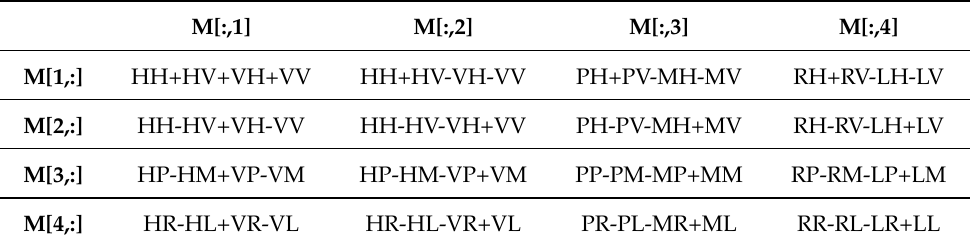
Table 1. Calculation of the MM elements. The individual elements result from different polarization states of PSG and PSA (first and second letter on the right side of each matrix element equation). Symbols are as in (2). All MM images are normalized by the first matrix element M[1,1].